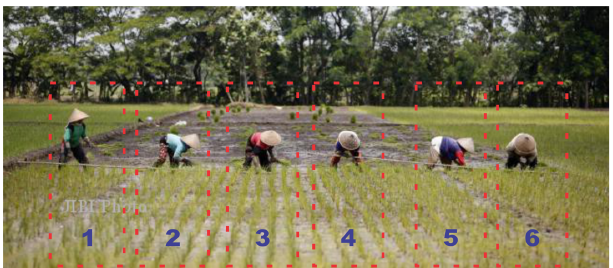
Fig. 2. Illustration of member positioning during Planting Rice Games (Source Image: http://solopos.com